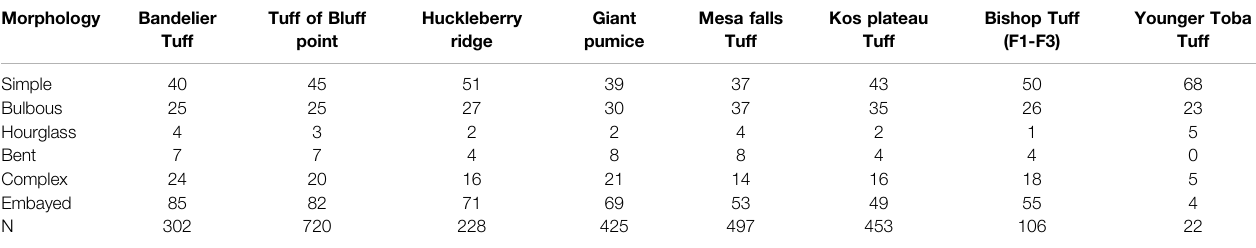
TABLE 2 | Observed morphology